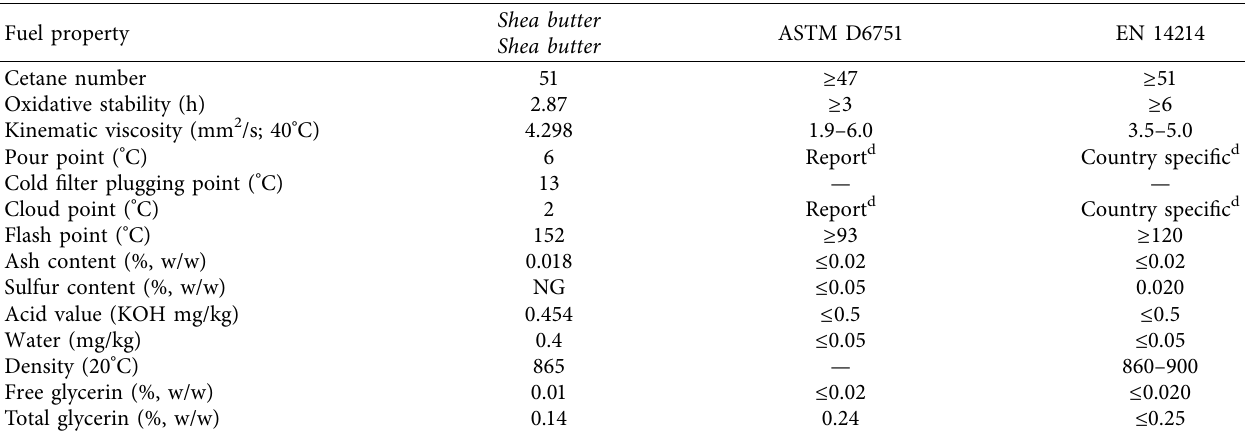
Table 4: Comparison of properties of the shea butter biodiesel and the standards of biodiesel United States and Europe and improvement of key cold flow